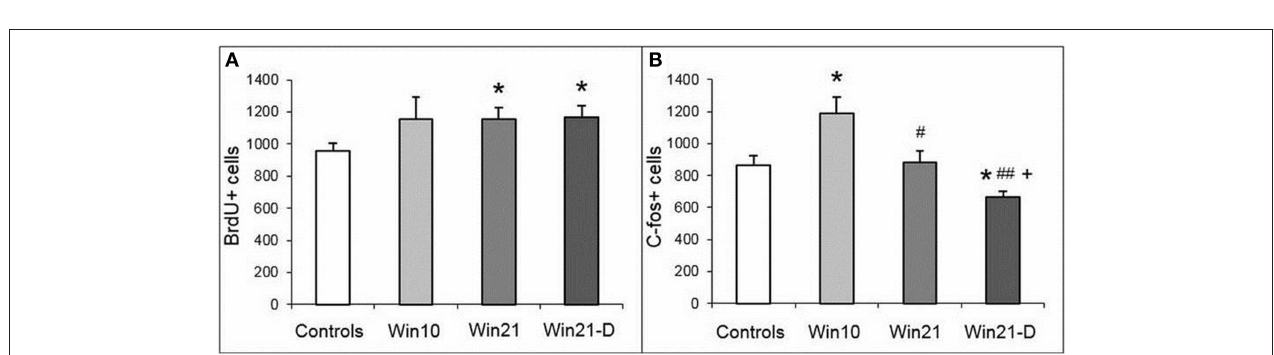
FIGURE 3 | Subclasses of progenitor cells in the SGZ of the DG of Nestin-GFP male mice. Numbers of dividing GFP + BrdU + progenitor cells (A) , ANP cells (B) , dividing ANP cells (C) , QNP cells (D) , dividing QNP cells (E), and Dcx + young neurons (F) . * P < 0.05 , ** P < 0.01 ; t -test.